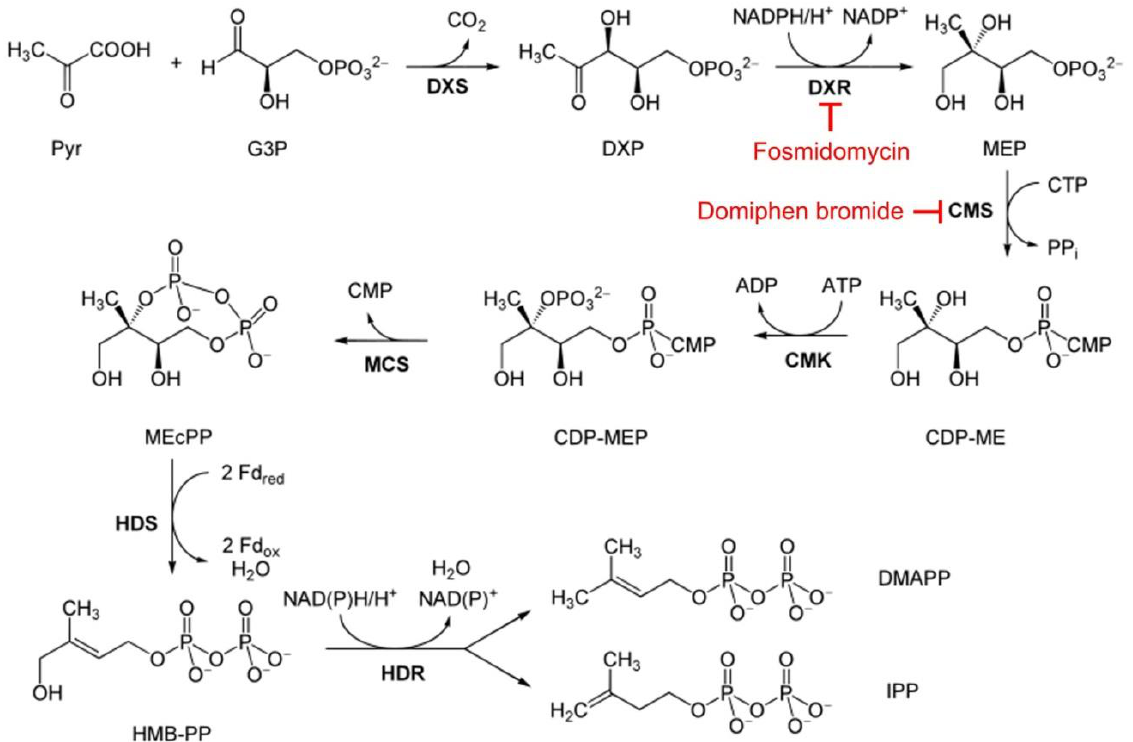
Figure 1. MEP pathway in P. falciparum . Abbreviations: pyruvate (Pyr), glyceraldehyde 3-phosphate (G3P), 1-deoxy-D-xylulose 5-phosphate (DXP), DXP synthase (DXS), DXP reductoisomerase (DXR), 2- C -methyl-D-erythritol 4-phosphate (MEP), MEP cytidylyltransferase (CMS), 4-diphosphocytidyl- 2- C -methylerythritol (CDP-ME), CDP-ME kinase (CMK), CDP-ME 2-phosphate (CDP-MEP), 2- C -